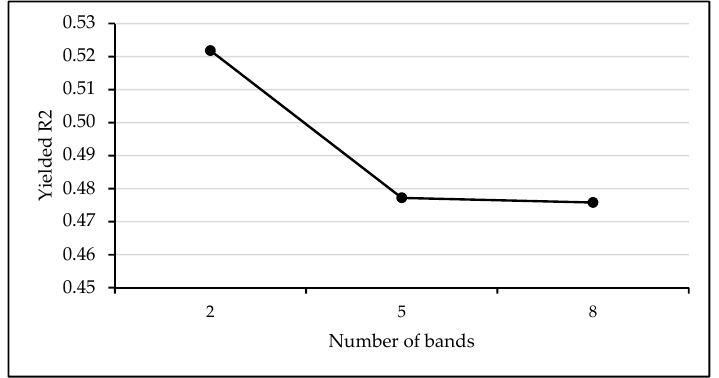
Figure A3. Variation of the models’ R 2 as a function of the number of bands involved in machine learning modelling using the spectral data from Sentinel-2 images (SP_S2). The highest R 2 was achieved using two bands: Centered at 490 nm and 665 nm. Table A1. Summary of PROSPECT and PROSAIL parameters as used in different studies.